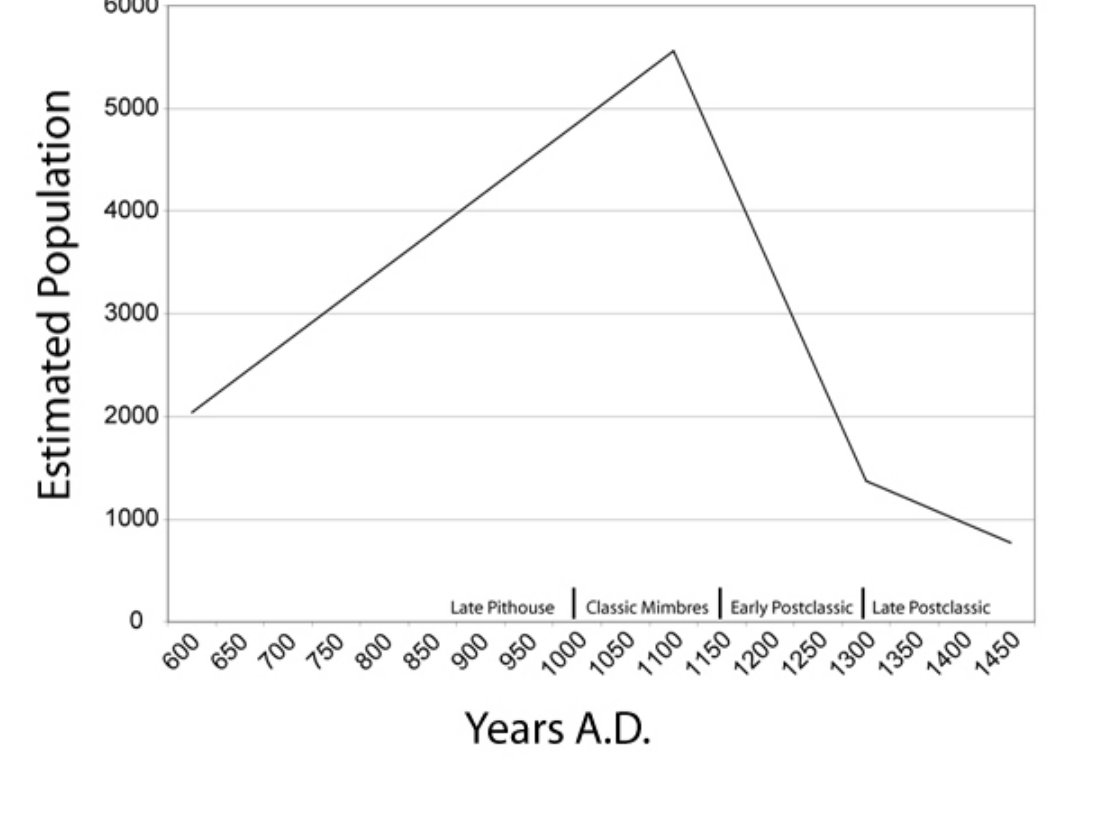
Fig. 4 . Population trends in the Mimbres area. Source: Peeples 2010, unpublished manuscript